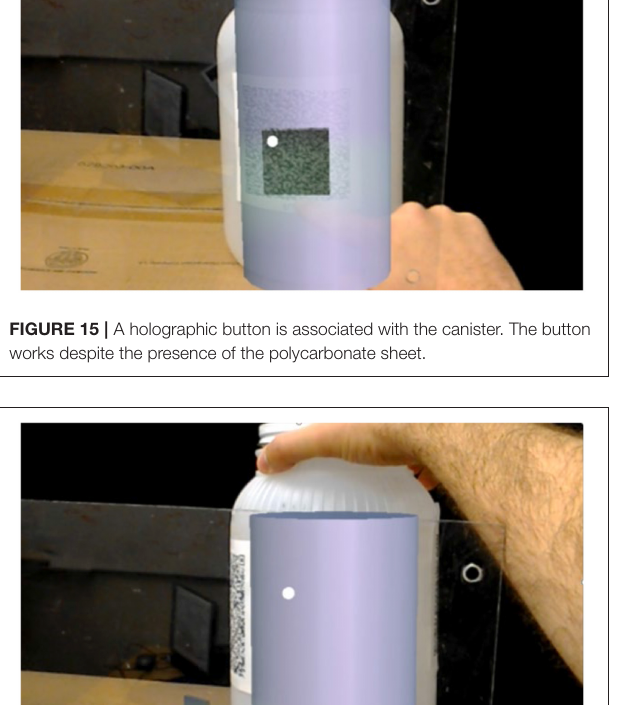
“Identification Number” field and the “Material Name” field have both been changed in a hands-free manner using the cursor and voice commands/voice recognition. An orthorectified view of an